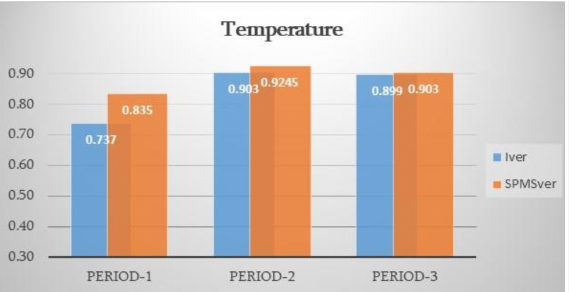
Figure 9. Illustration of the medians of the index of agreement values for the Temperature of the Iver (in blue) in comparison to the SPMSver (in orange) for the three meteorological periods.